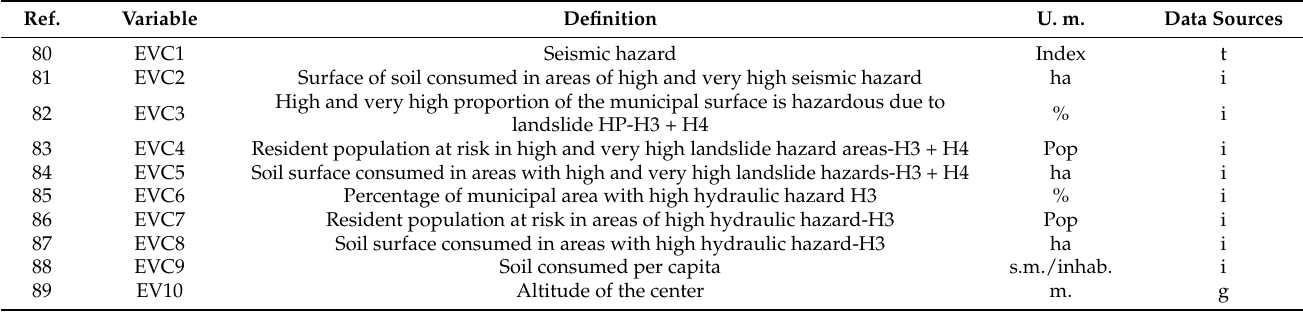
Table 7. Environmental capital